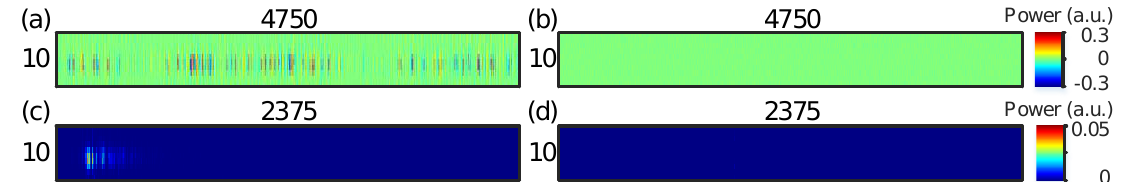
Figure 10. CNN model’s input images of the ( a ) temporal and “infested”, ( b ) temporal and “healthy”, ( c ) spectral and “infested”, and ( d ) spectral and “healthy”